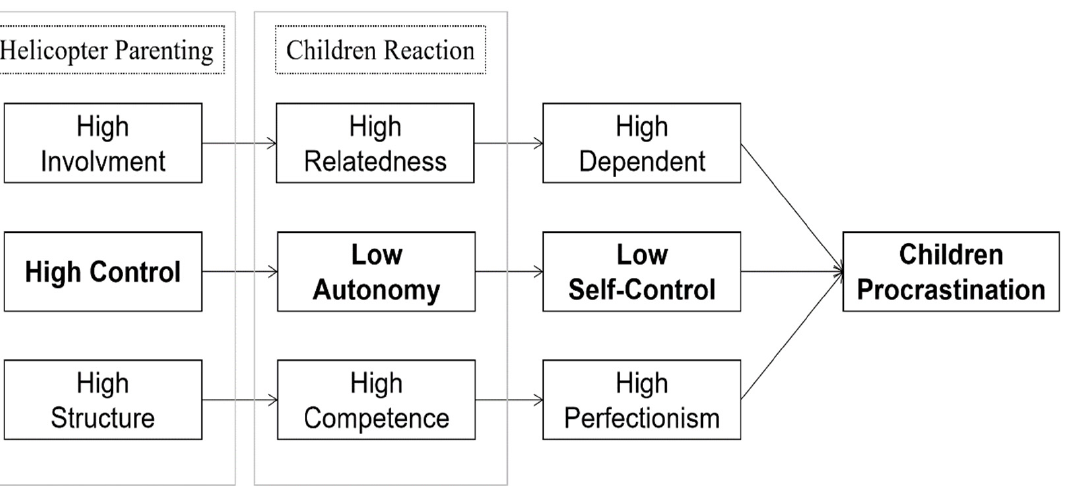
Figure 1. The pathway of helicopter parenting and children’s procrastination based on the Self-System Process Model.